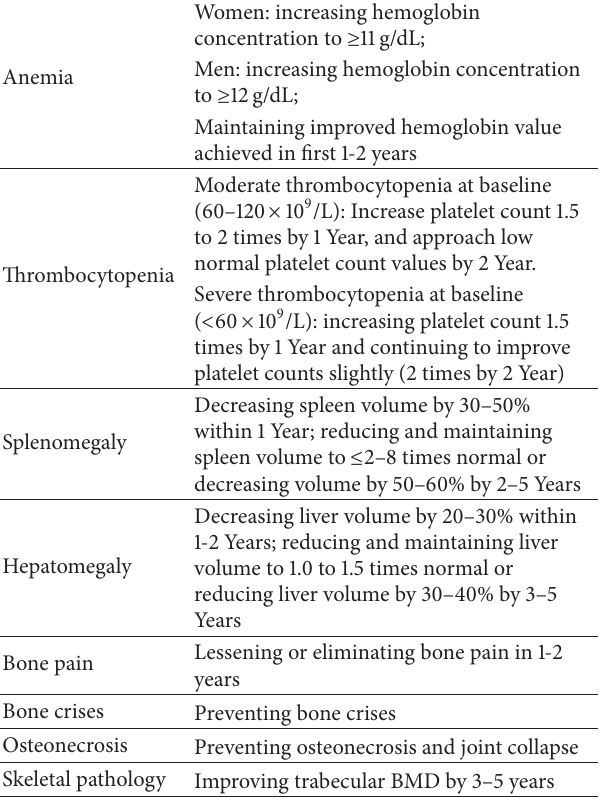
Table 2: Long-term goals (2–5 years) for adults (Pastores et al., 2004 [7]).